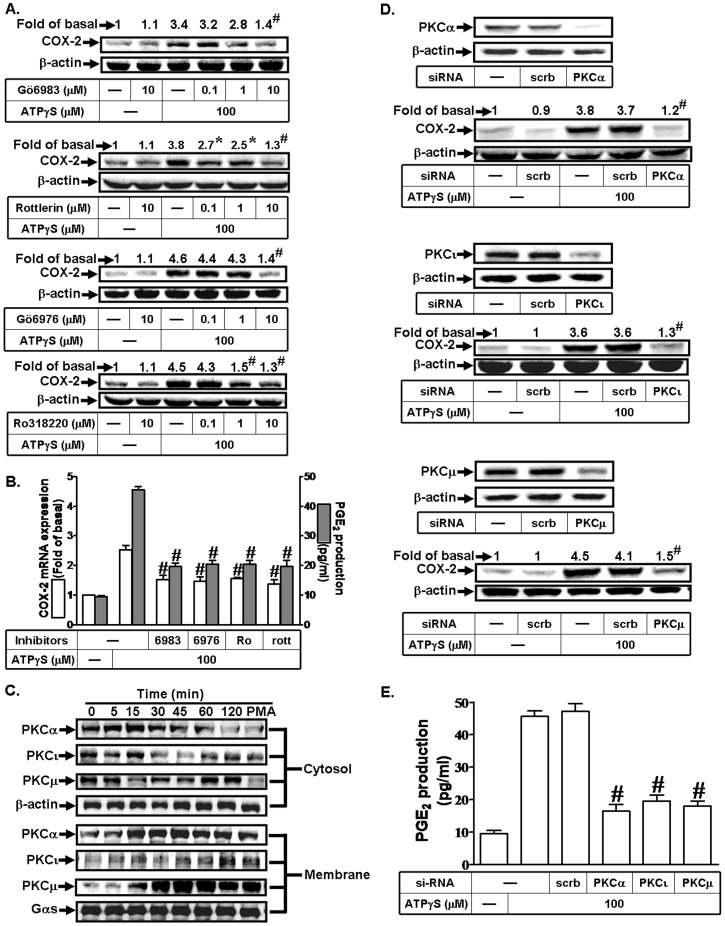
ATPγS regulates COX-2 expression via PKCs in A549 cells.Cells were pretreated with Gö6983, Gö6976, Ro318220, or Rottlerin for 1 h, and then incubated with ATPγS for (A) 6 h or (B) 2 h. The levels of COX-2 (A) protein and (B) mRNA were analyzed by western blot and real-time PCR, respectively. (A) The media were collected and analyzed for PGE2 release. (C) Cells were treated with ATPγS (100 µM) for the indicated time intervals or PMA (1 µM) for 15 min. The cytosolic and membrane fractions were prepared and analyzed by western blot using an anti-PKCα, anti-PKCι, or anti-PKCμ antibody. β-actin and Gαs were used as a marker protein for cytosolic and membrane fractions, respectively. (D, E) Cells were transfected with siRNA of scrambled, PKCα, PKCι, or PKCμ, and then incubated with ATPγS for 6 h. The expression of PKCα, PKCι, PKCμ, and COX-2 were analyzed by western blot. The media were collected and analyzed for PGE2 release. Data are expressed as mean±S.E.M. of three independent experiments. *p<0.5; #
p<0.01, as compared with the cells exposed to ATPγS alone (A, B) or the cells transfected with scrambled siRNA and exposed to ATPγS alone (D, E).